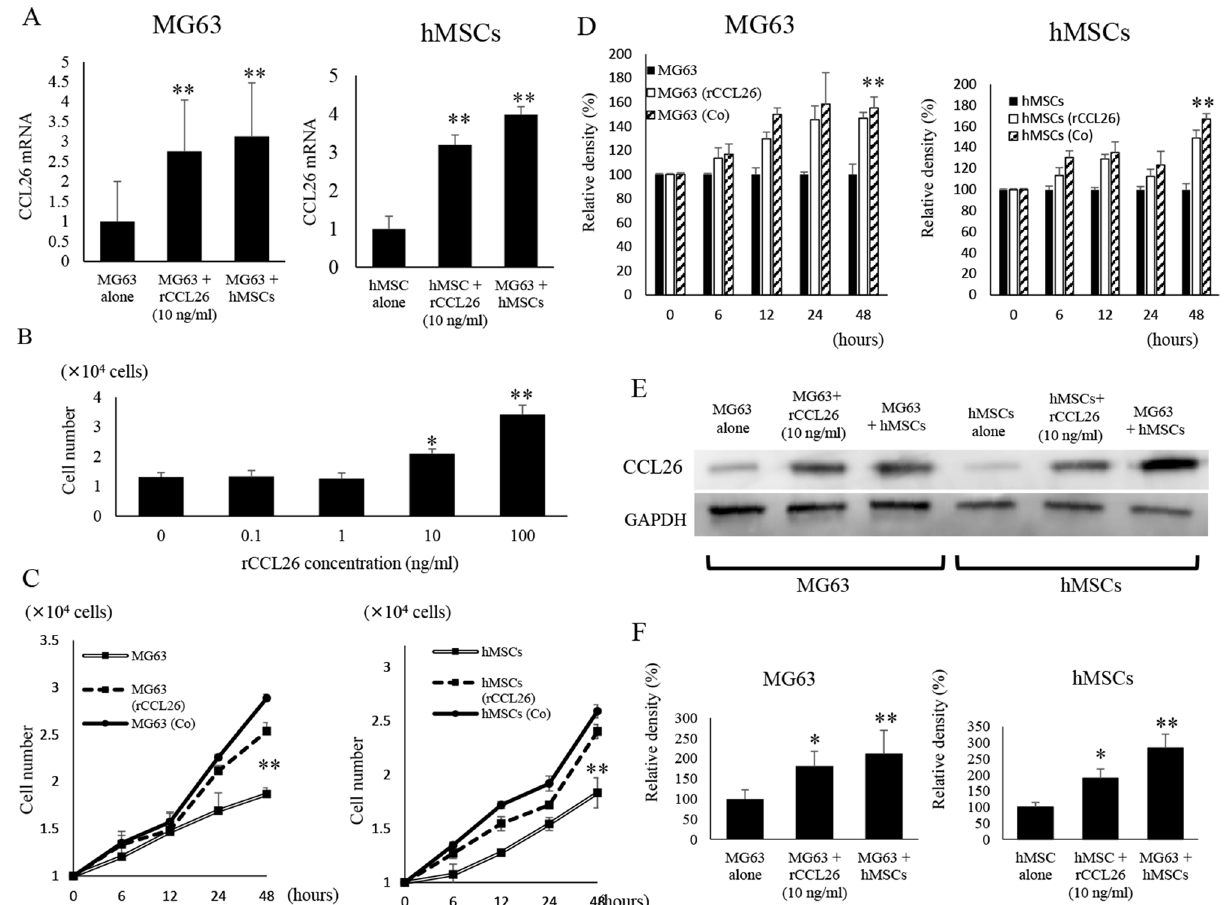
Figure 2. Changes in CCL26 expression and cell growth in MG63 and hMSCs induced by the co-culture condition and rCCL26 administration. ( A ) Changes in CCL26 mRNA expression in MG63 and hMSCs were assessed by qRT-PCR. The co-culture and rCCL26 addition significantly increased the expression of mRNA of CCL26. ( B ) rCCL26 was administered to mono-cultured MG63. There was a significant increase in cell growth with rCCL26 at 10 ng/ml. (*) p < 0.05, (**) p < 0.01. ( C ) Changes in cell proliferation induced by Co-cultured condition and recombinant CCL26 administration in MG63 and hMSCs. ( D ) Changes in the degree of cell proliferation in the untreated, co-culture, and recombinant groups were analyzed by performing cell proliferation assay via BrdU incorporation. ( E ) Changes inCCL26 protein expression of intra-cellular hMSCs and MG63 were assessed by western blot analysis. The co-culture and addition of rCCL26 increased the expression ofCCL26 protein in MG63 and hMSCs. ( F ) The quantification of western blot analysis. Data represents represent the mean ± SD of three independent experiments. p < 0.05 was considered to indicate significance: (*) p < 0.05, (**) p < increased compared with hMSCs alone (1.83 ± 0.64 × 10 5 cells) (p < 0.01) (Fig. 2C). Next, we used a bromod- eoxyuridine (BrdU) proliferation assay to determine the effects of rCCL26 (146.7 ± 4.9%) and co-culture condi- tion (155.4 ± 9.1%) compared to the proliferation of untreated MG63 cells (100%). The rCCL26 (148.9 ± 7.5%) and co-culture group (167 ± 5.1%) showed markedly increased proliferation than the untreated group using BrdU assays in hMSCs (100%). (Fig. 2D). Additionally, we observed that the expression of intracellular CCL26 proteins in rCCL-26 administration (182 ± 16.3%) (p < 0.05) and co-cultured with hMSCs (212 ± 28%) (p < 0.01) significantly increased compared to levels with MG63 alone. We performed immunoblot analysis to evaluate the protein levels of CCL26 in each group (Fig. 2E). Western blot analysis showed that the expression levels of CCL26 in MG63 were significantly increased with rCCL26 administration (182 ± 16.3%) (p < 0.05) and MG63 co-cultured with hMSCs (212 ± 28%) (p < 0.01) compared to levels with MG63 alone. CCL26 expression levels in hMSCs were significantly increased after rCCL26 administration to hMSCs (190 ± 28%) (p < 0.05) and hMSCs co-cultured with MG63 (284 ± 43%) (p < 0.01) (Fig. 2F). Inhibition of CCL26 expression by anti-CCL26 antibodies. Blockade of the CCL26 communication loop using anti-CCL26 mAb resulted in reduced CCL26 levels in both MG63 and hMSC in co-culture. Indeed, MG63 co-cultured with hMSCs and treated with anti-CCL26 Ab showed lower CCL26 mRNA levels (58 ± 4.8%) (p < 0.05) than untreated MG63 co-cultured with hMSCs (449 ± 52.4%) (p < 0.01) (Fig. 3A). We observed